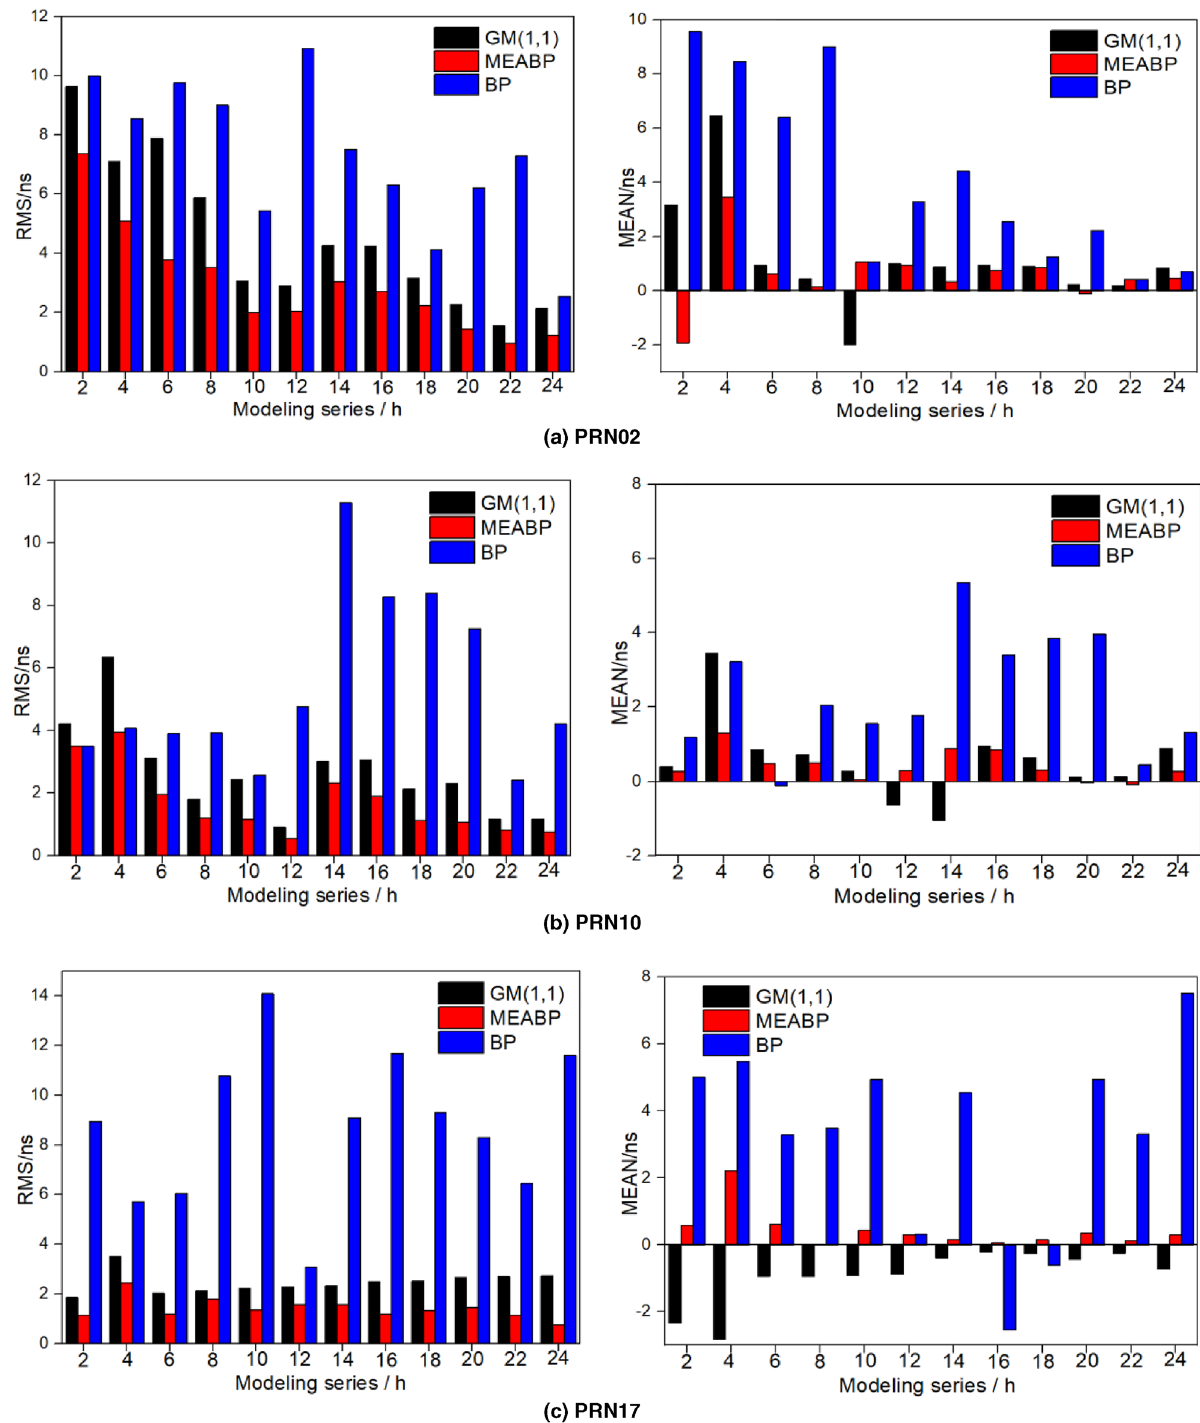
Figure 6. Modeling and prediction accuracy statistics of clock bias sequences with different lengths of three